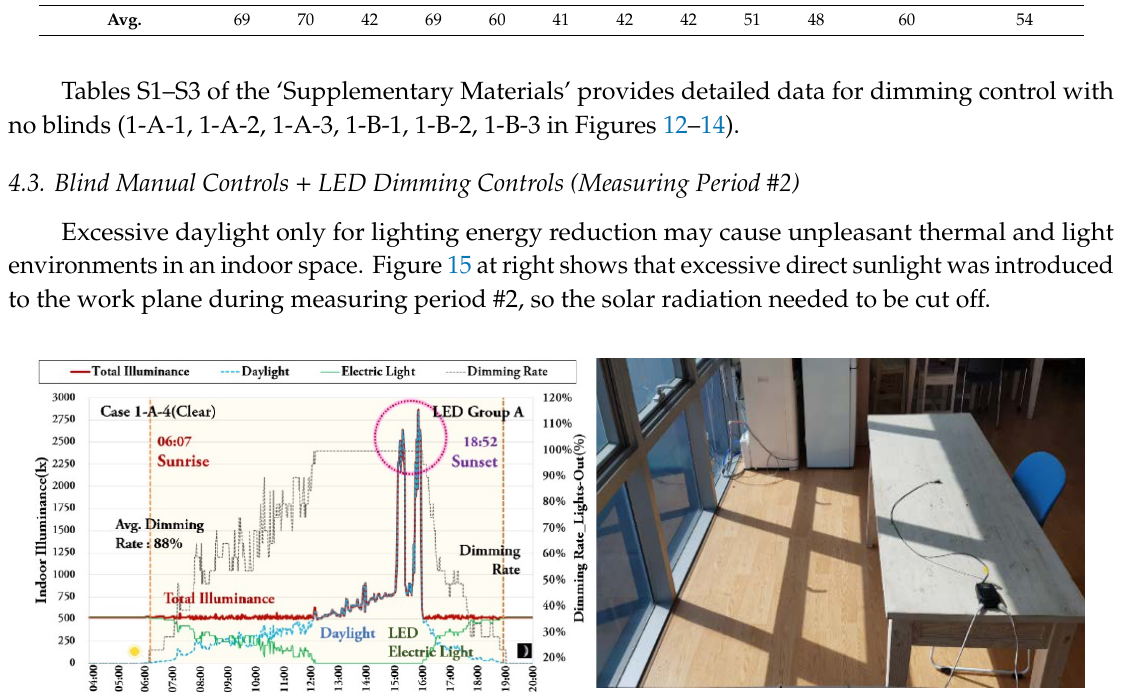
Sky Condition Table 8. Dimming rate for sky conditions with no blind (Avg.1: Case 1-A–2-A, Avg.2: Case 1-A–3-A).